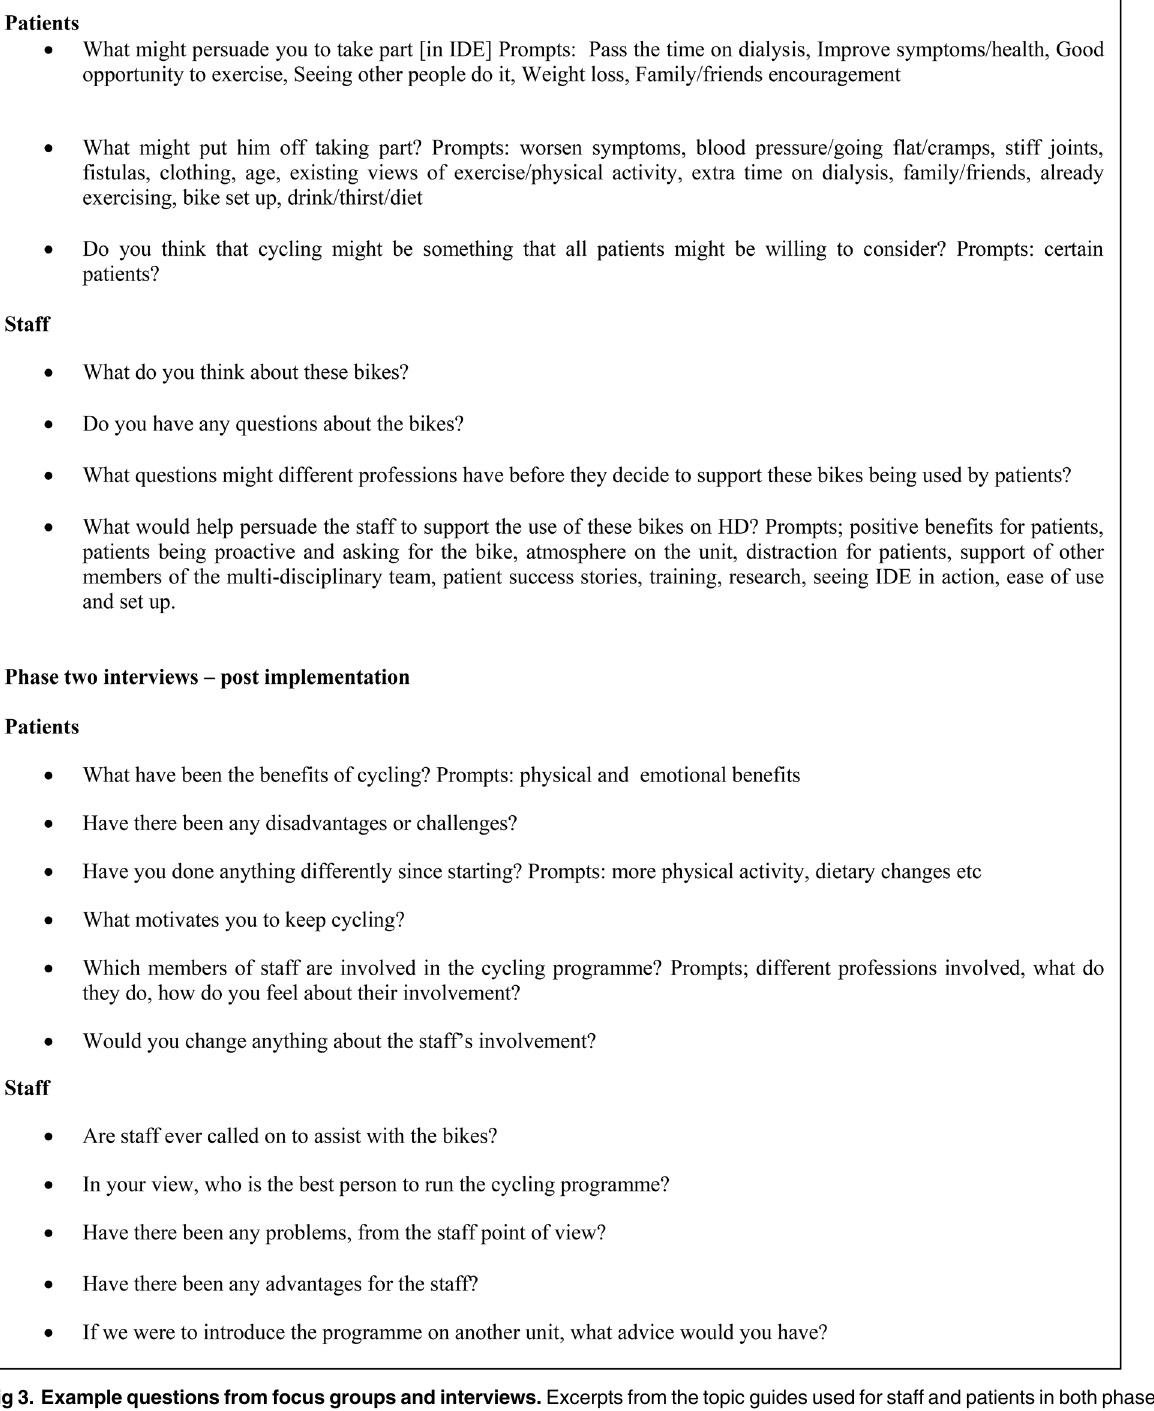
Fig 3. Example questions from focus groups and interviews. Excerpts from the topic guides used for staff and patients in both phases of the study.